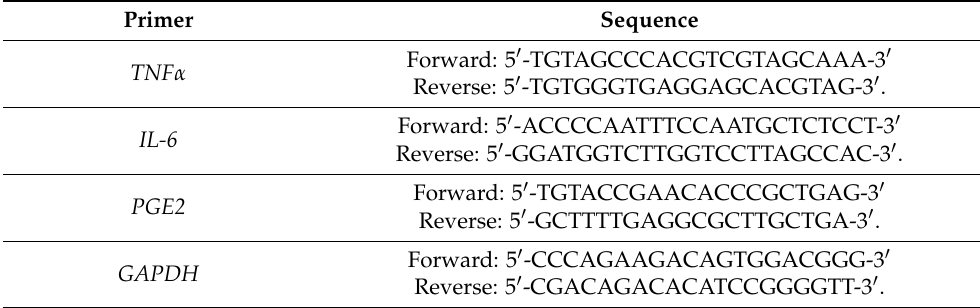
Table 1. Sequences of the primers